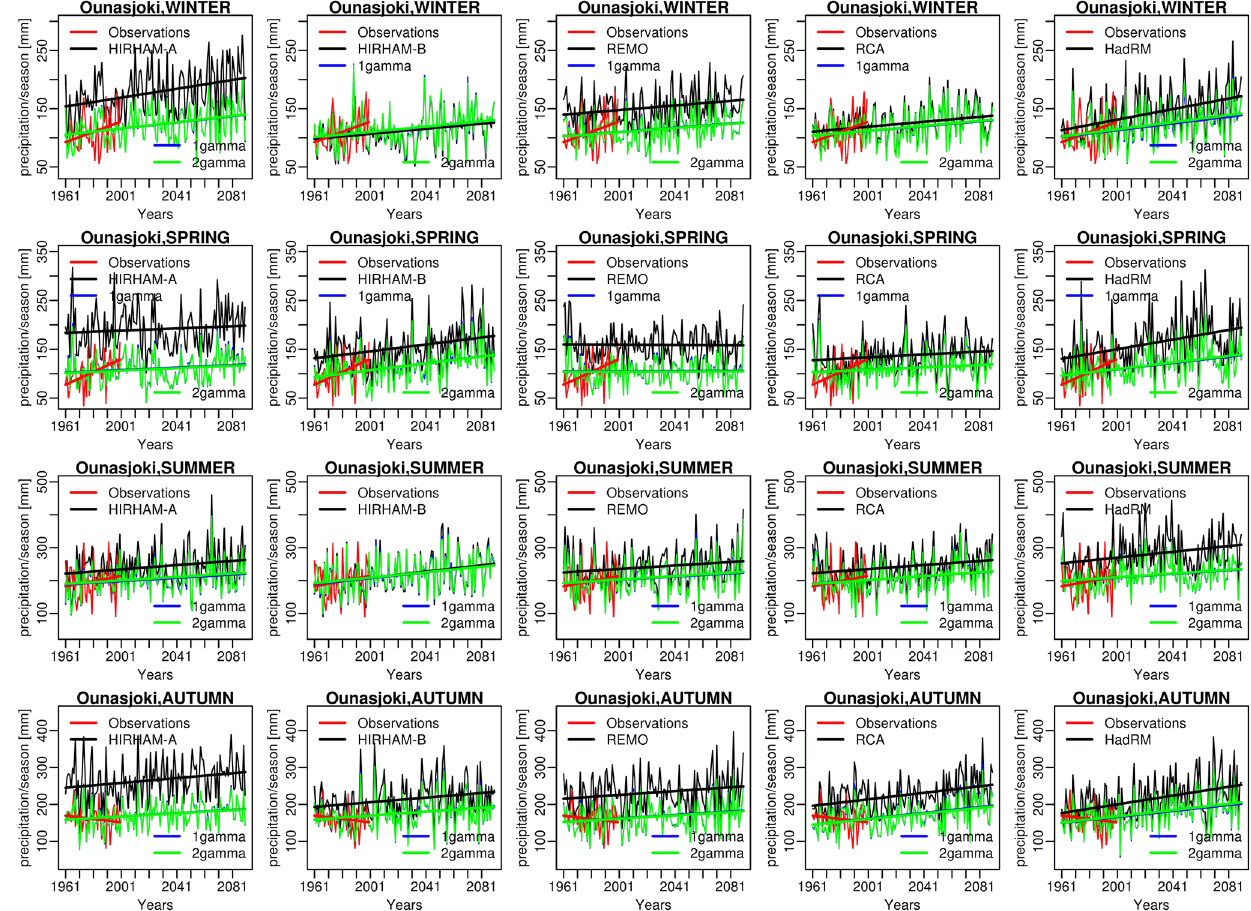
Figure 10. Seasonal trends in observed (red, 1961–2000) and RCM simulated seasonal precipitation accumulation in Ounasjoki catchment during 1961–2090. Uncorrected RCM precipitation in black, precipitation adjusted with single gamma in blue and with double gamma in